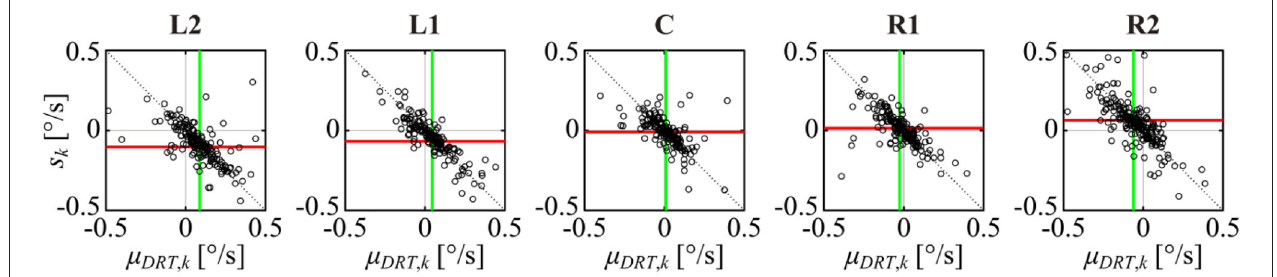
FIGURE 9 | Scatter plot of a DRT trend µ DRT , k and the reconstructed MS trend s k for the kth sample paths across all samples of all subjects for each target position. The green vertical line and the red horizontal line represent the mean value of µ DRT , k and s k , respectively. The dotted black line is the complete balanced condition defined by Equation